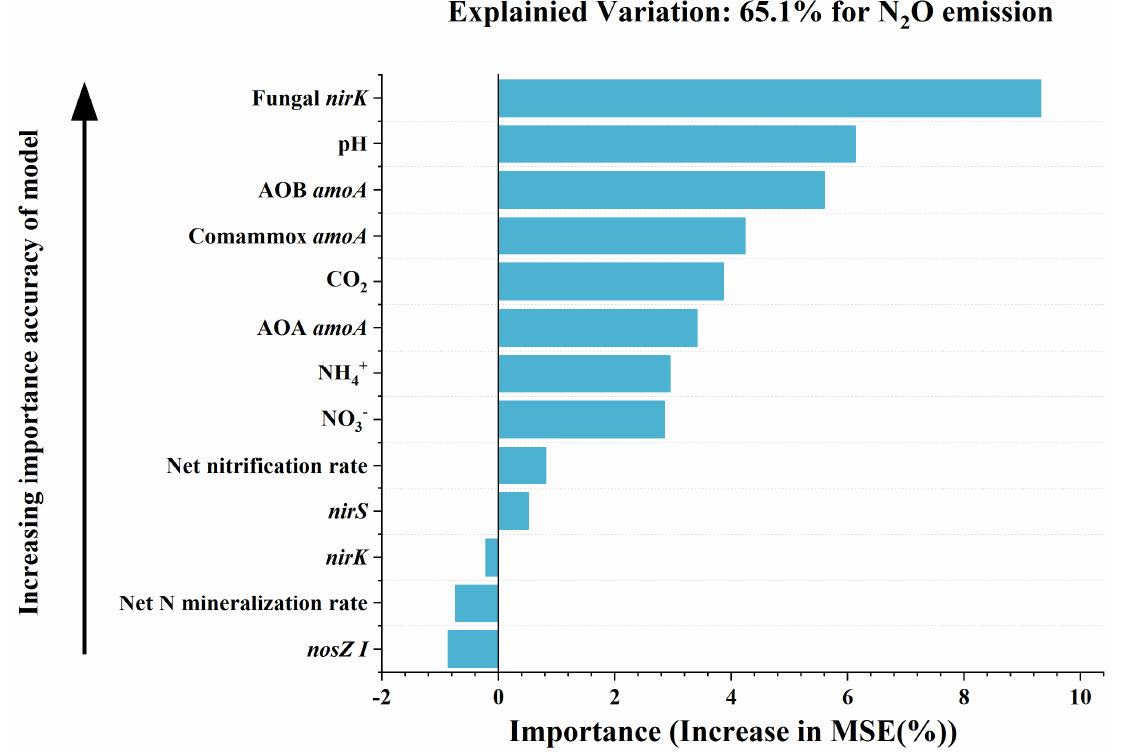
Figure 4. Random forest analysis to assess the predictor importance of N cycling gene abundance and environmental factors as drivers for the N 2 O production.